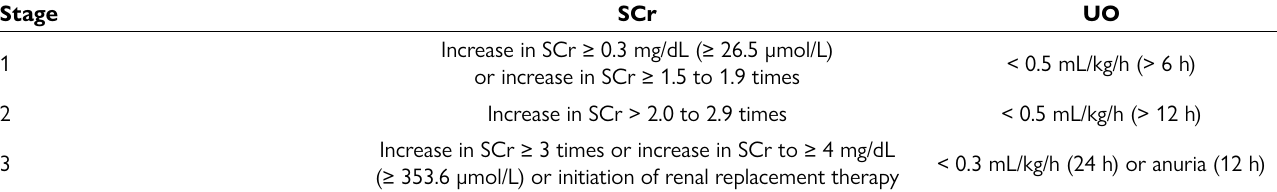
Table 1. Stages of acute kidney injury (AKI) [37].